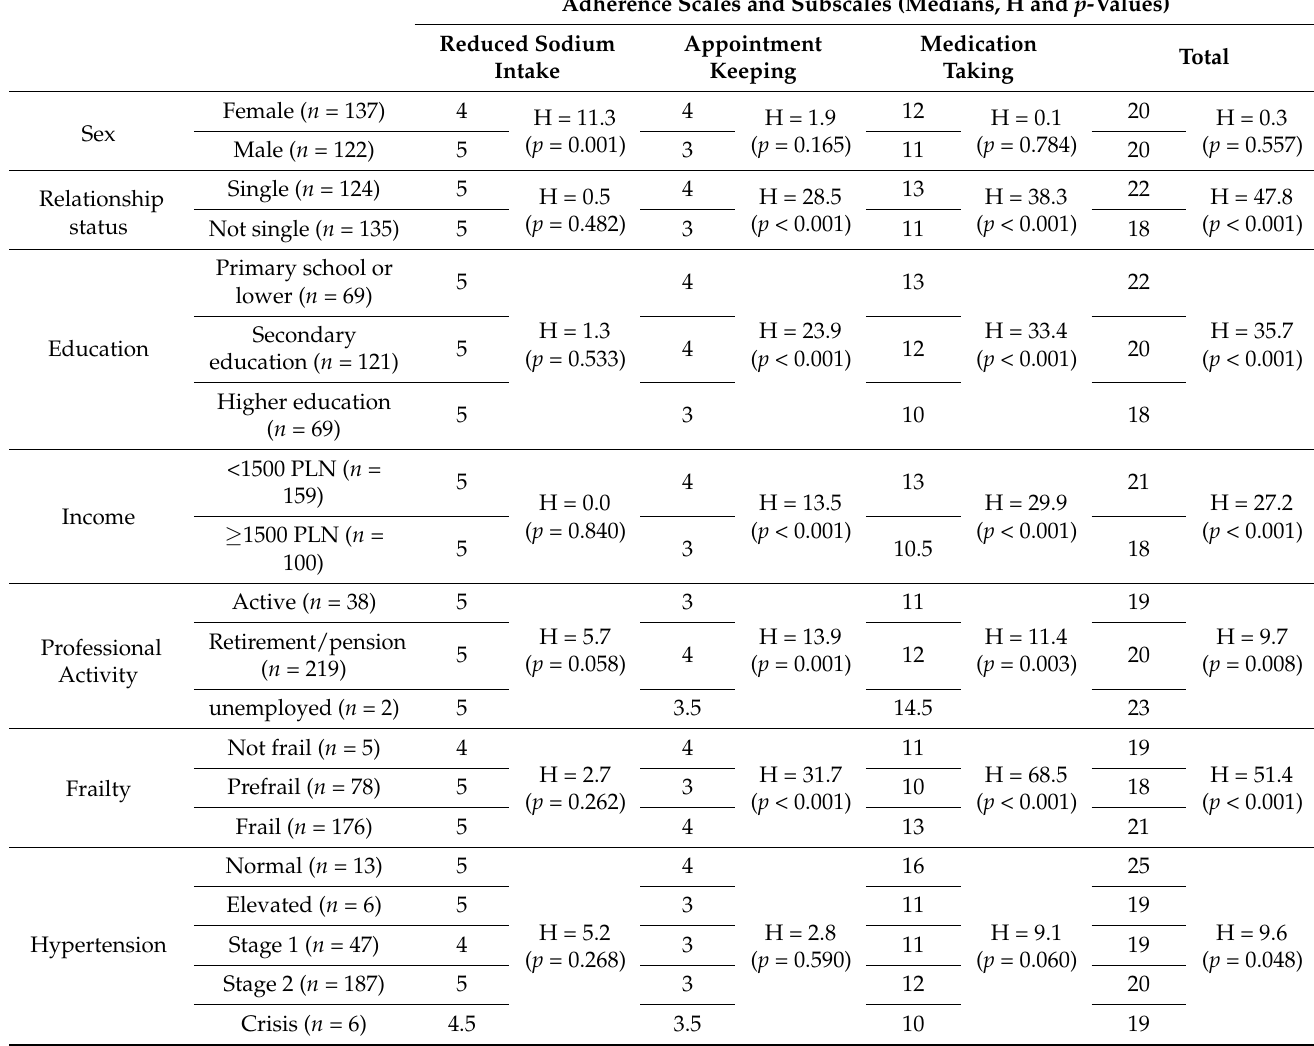
Table 2. Differences in Hill—Bone subscales in HBP patients given clinical and sociodemographic data. Adherence Scales and Subscales (Medians, H and p